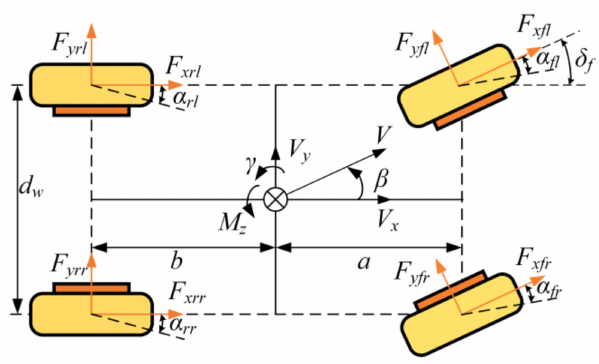
Figure 3. Vehicle 7-DOF dynamic model